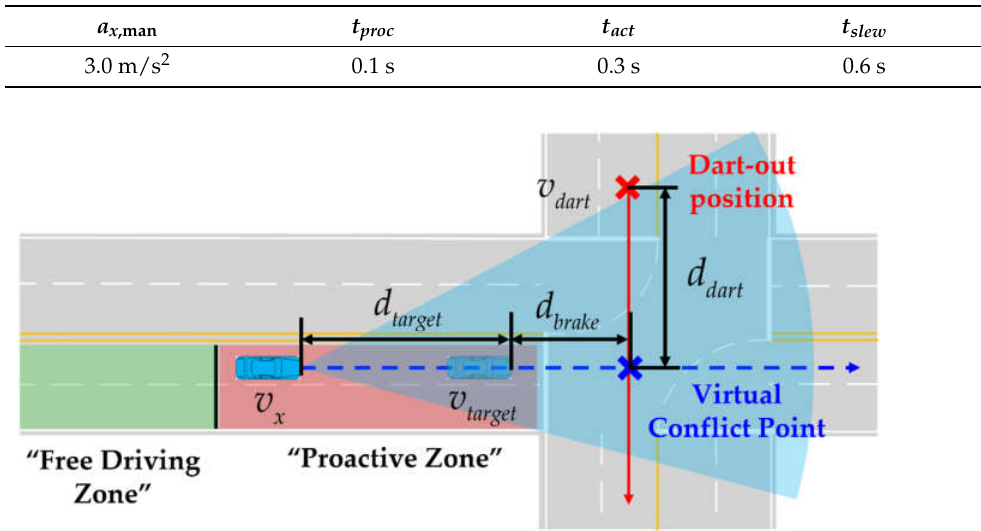
Table 1. Parameters for target state decision for approach motion.